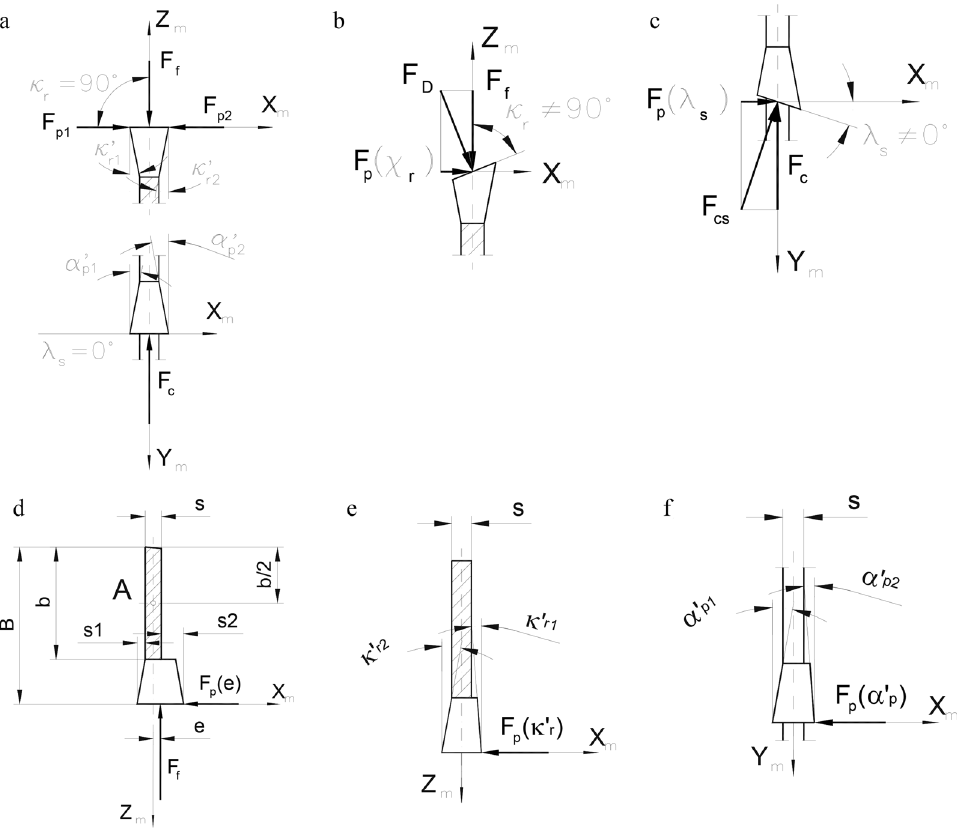
Figure 3. Transverse loads of the saw blade as a function of its geometry in the sawing machine’s coordinate system (X m , Y m , Z m ): (a) typical blade with the swaged saw set; (b) effect of the cutting edge angle κ r ; (c) effect of the angle of inclination of the main cutting edge λ s ; (d) effect of the difference in the values of the side saw sets s 2 > s 1 ; (e) effect of the difference in the values of tool minor cutting edge angles κ r1 ’ < κ r2 ’ ; (f) effect of the difference in the values of the rear angles of clearance α p1 ’ > α p2 ’